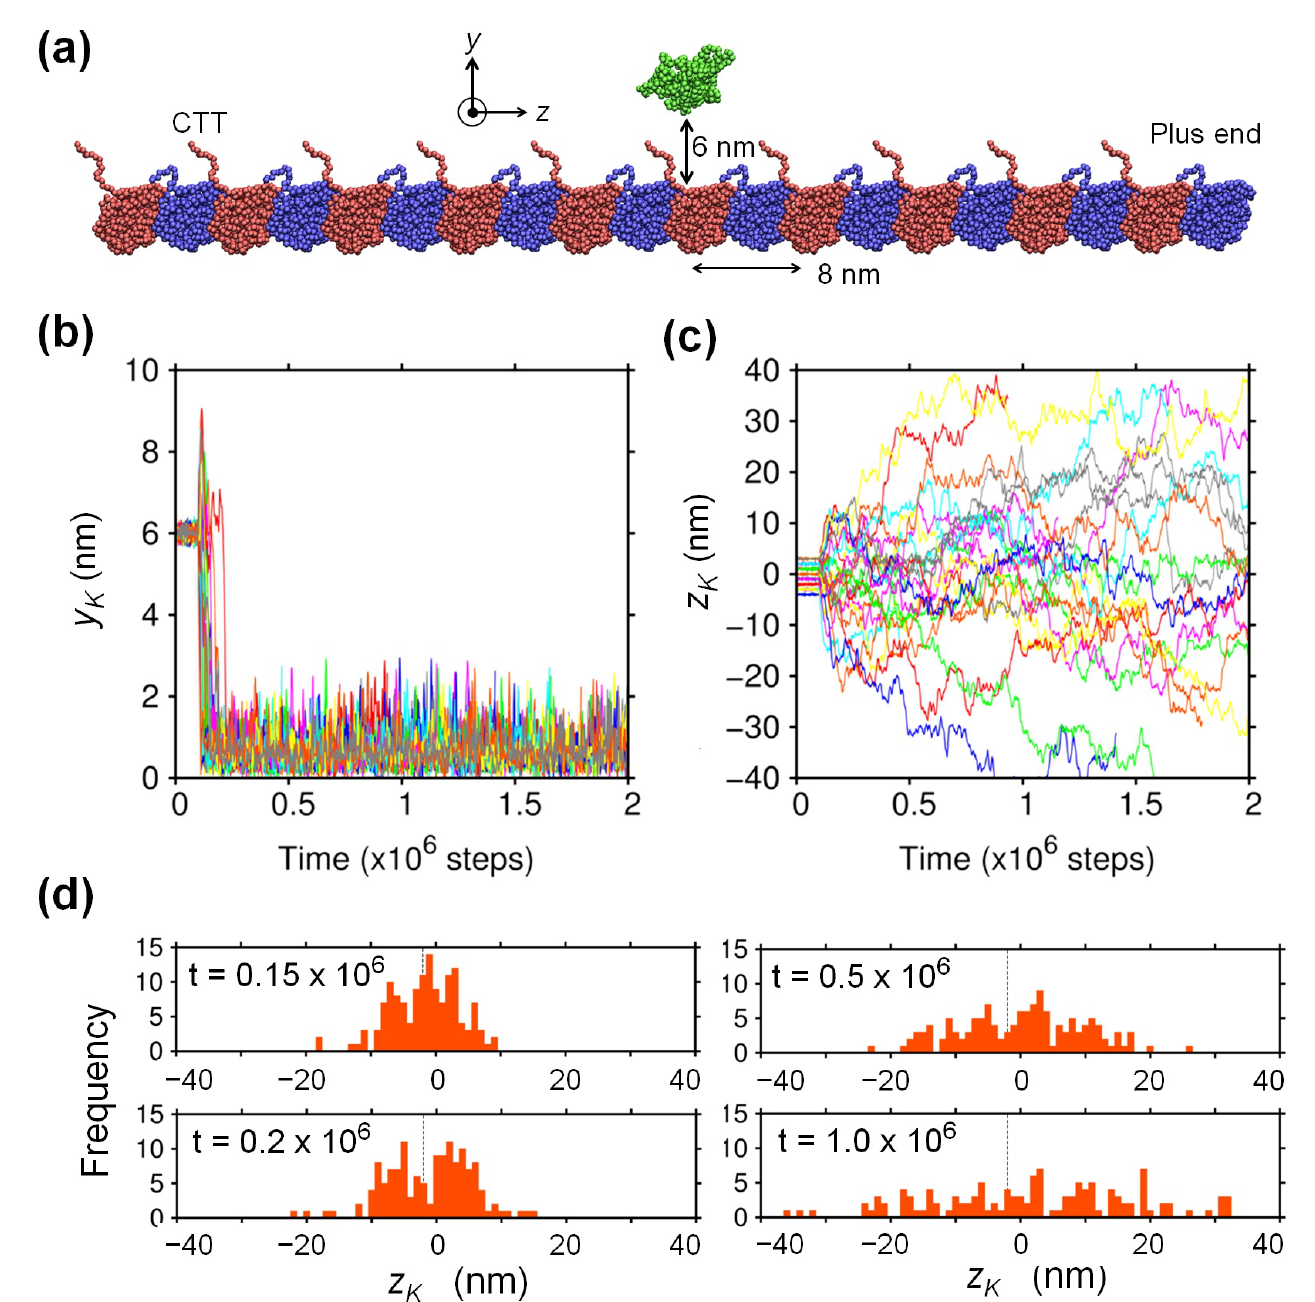
Figure 1. Binding of KIF1A to the microtubule (MT). ( a ) The system we employed in this study is composed of a monomeric KIF1A (green) and a single protofilament of the MT with 20 tubulins (blue: α tubulin; red: β tubulin). KIF1A was initially moved from the original bound position in the EM structure [20] by +6 nm along the y -axis (the mass center of the bound position of KIF1A is used as the coordinate origin). ( b , c ) Time courses for y - and z -positions of the mass center of KIF1A, denoted by y K and z K , respectively, are shown. Sample trajectories (randomly selected 24 runs) where binding of KIF1A to the MT was observed are displayed. The time course data are shown until KIF1A dissociated from the MT. Note that the unit time step in this study corresponds to 3.3 × 10 − 5 ns and that the translational motion of KIF1A was enhanced by ∼ 100-fold because we employed a low viscosity (see the Methods). For equilibration, KIF1A was restrained at each initial position for the first 0.1 × 10 6 steps before starting the observation of the binding. ( d ) Time evolution of z K for the ensemble of KIF1A that started from z K = − 2 nm (142 runs); the distributions at t = 0.15, 0.2, 0.5, and 1.0 × 10 6 steps are shown. CTT, C-terminal